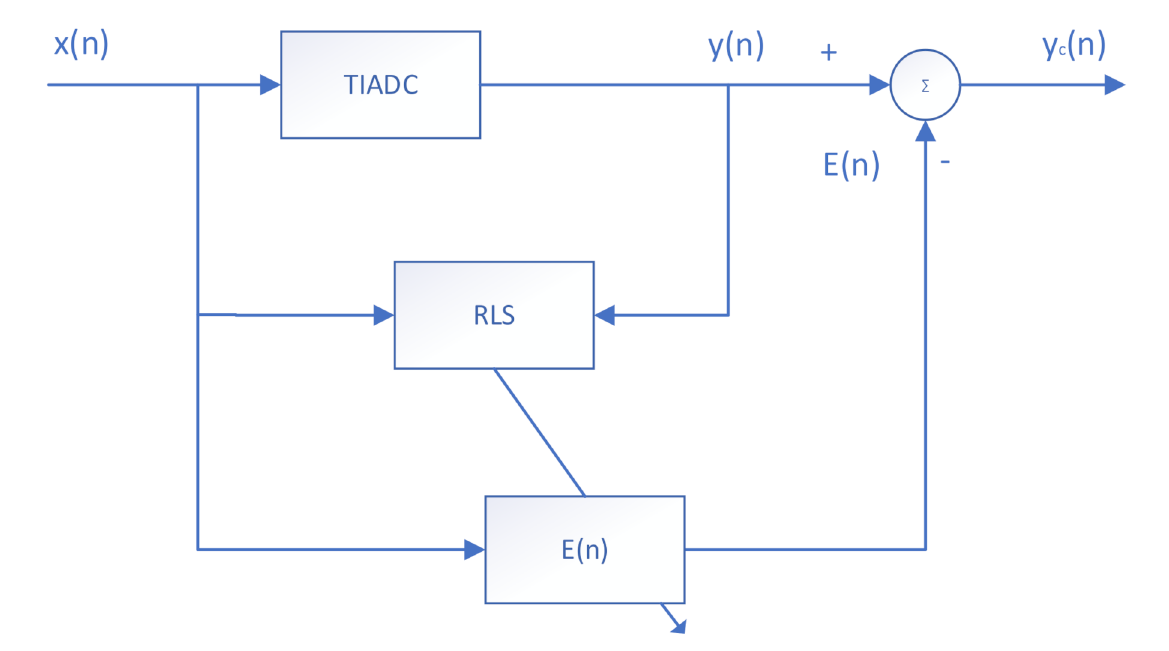
Figure 5. Overall error reconstruction and compensation structure of the TIADC.